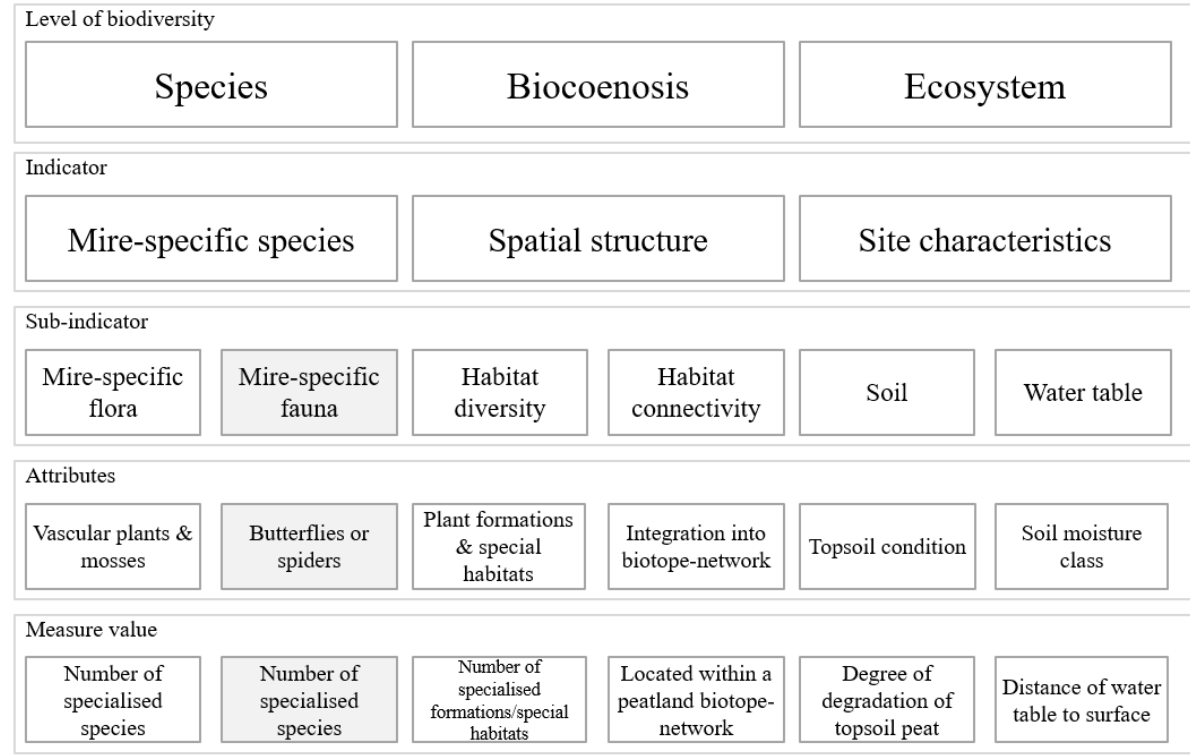
Figure 1. System of indicators for assessing mire-specific biodiversity. The attribute ‘Butterflies or spiders’ within the level of species was proposed as possibly available, but needed to be excluded within the suggested approach due to lack of